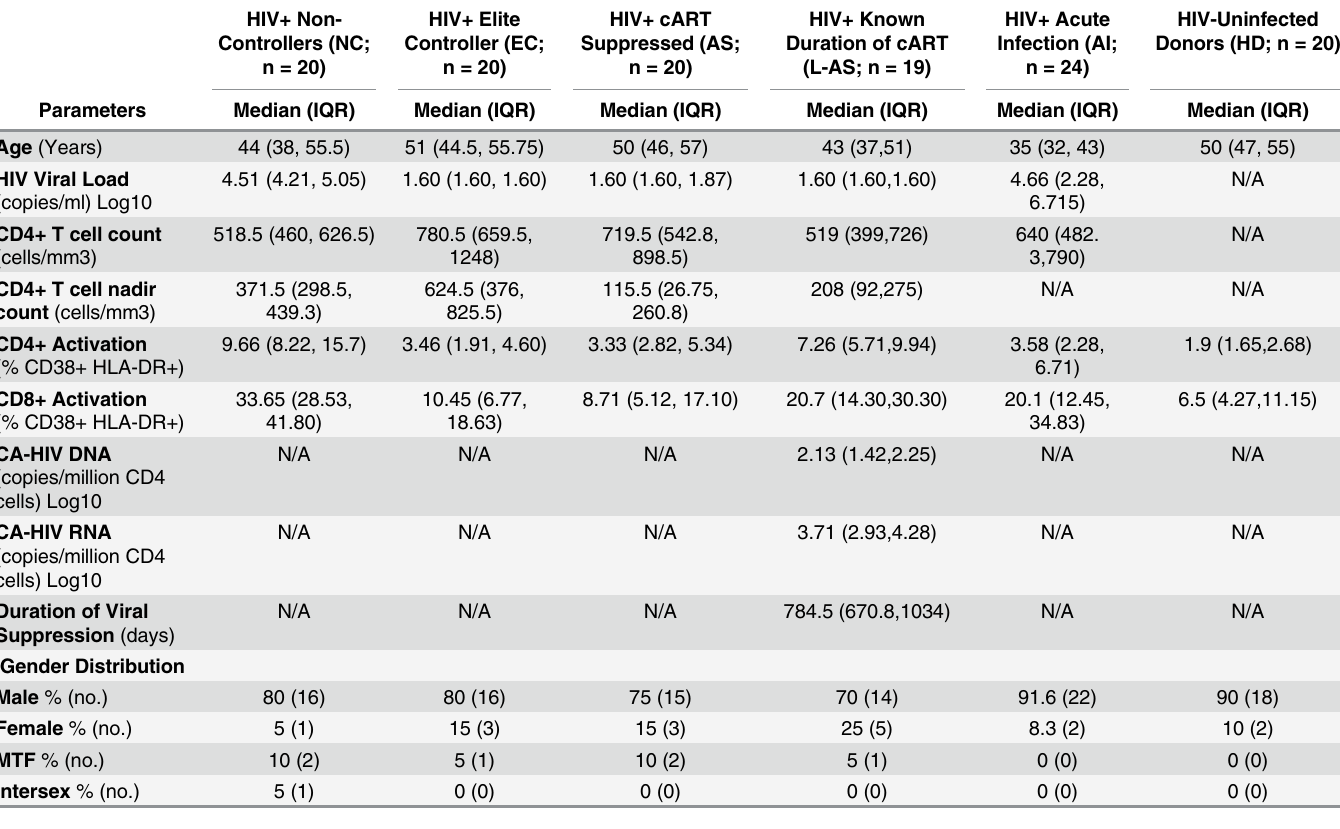
Table 1. Participant